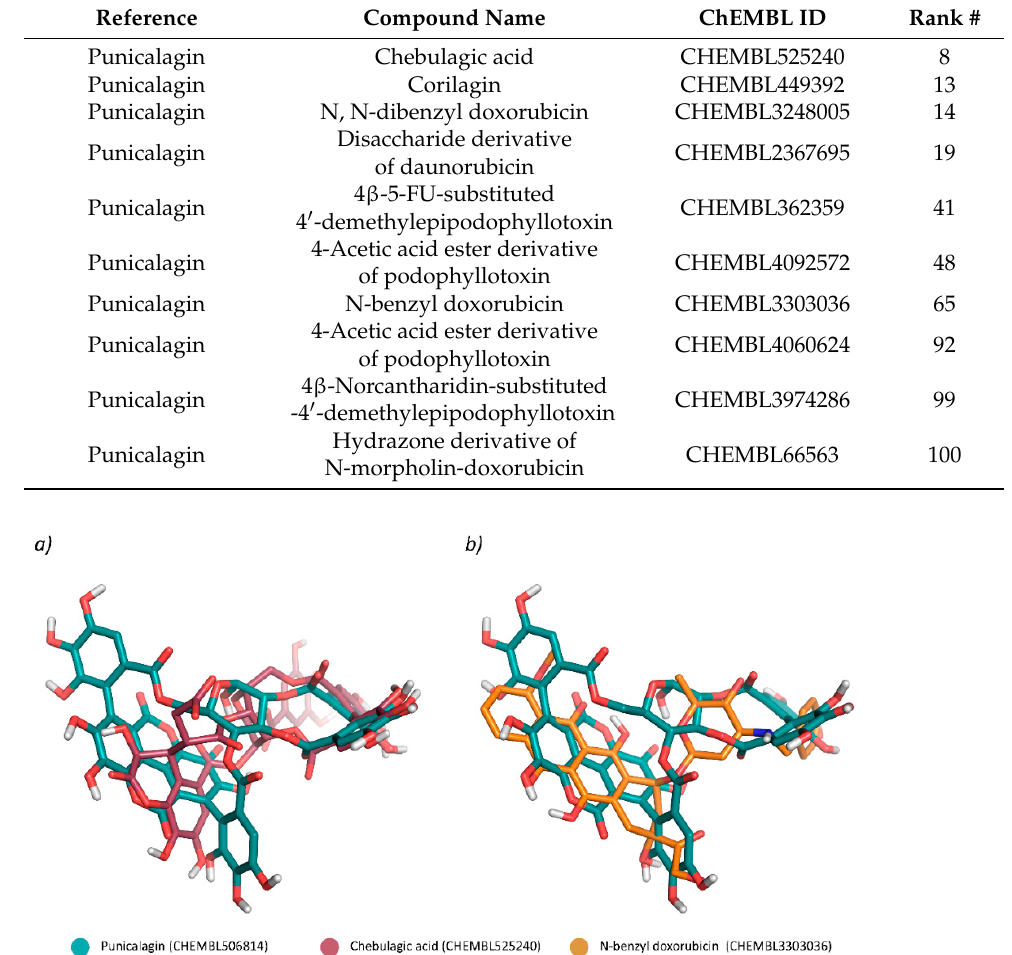
Figure 4. Ligand-based alignments of punicalagin with the CHEMBL525240 (chebulagic acid) and CHEMBL3303036 (N-benzyl doxorubicin) compounds, predicted with ROCS. (Panel ( a )) shows the structures of punicalagin (dark teal sticks) and CHEMBL525240 (raspberry sticks) providing the best shape-based alignment. (Panel ( b )) shows the shape-based alignment obtained for punicalagin (dark teal sticks) with the CHEMBL3303036 (orange sticks) compound. The image was created with PyMol (The PyMOL Molecular Graphics System, Version 1.8, Schrödinger,